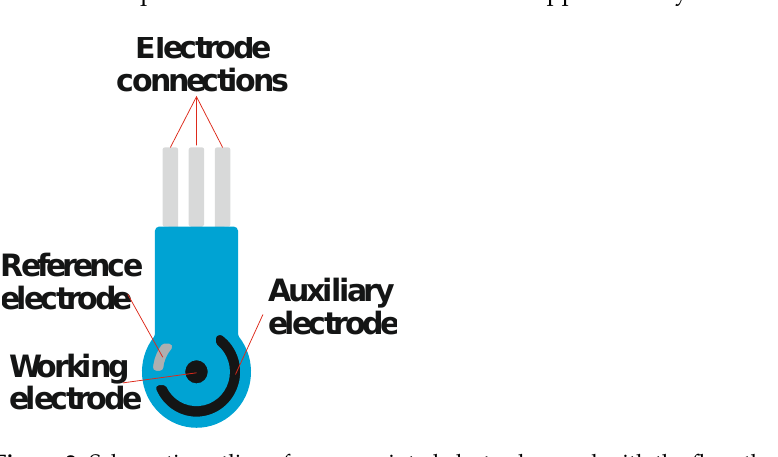
working electrode of 3.8 mm 2 . The schematic outline of an electrode strip is presented in Figure 2. Prior to use, the working electrode was consecutively modified with the CB suspension containing P[5]A and an electropolymerized layer of the MB and thionine. The modification protocol is described in Electronic Supplementary Information (ESI).